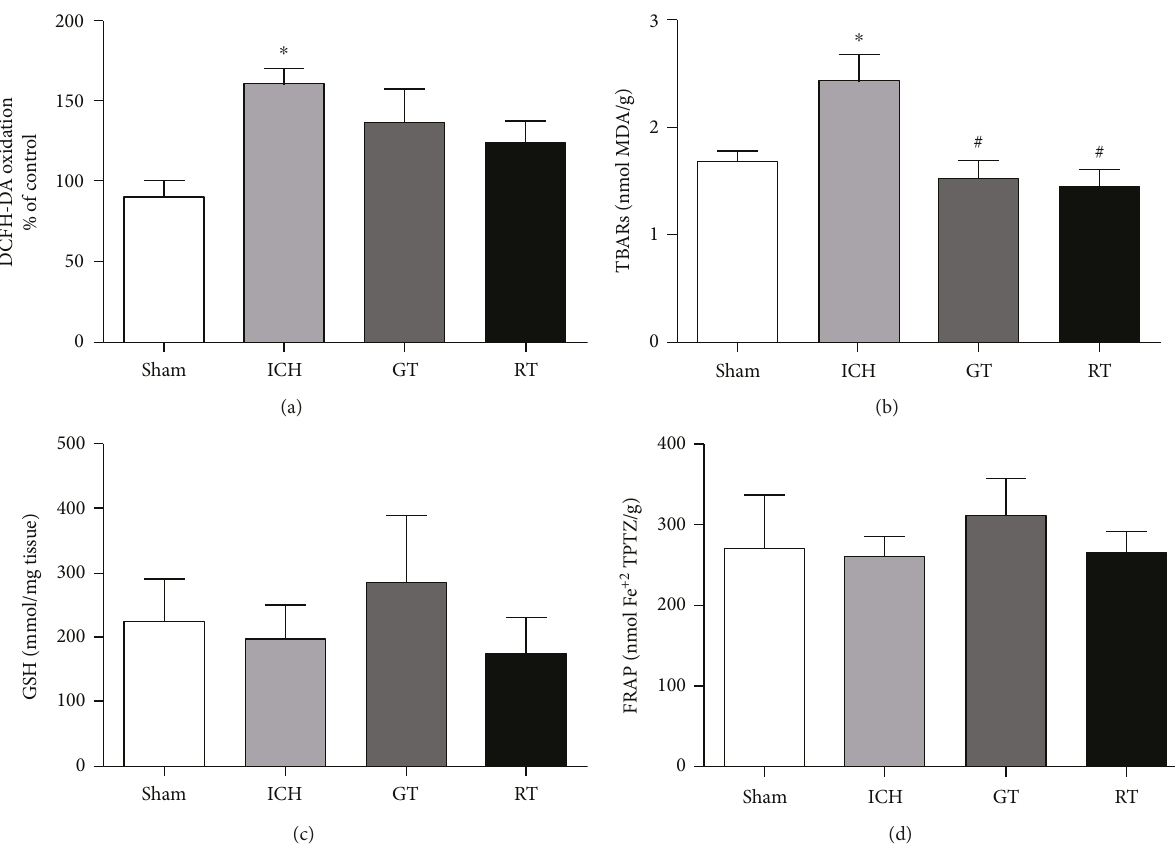
Figure 3: E ff ects of administration of green tea and red tea on oxidative stress, oxidative damage, and antioxidant markers on striatum after ICH in rats. (a) ROS levels by DCFH method; (b) lipid peroxidation by TBARS (thiobarbituric acid reactive substance); (c) glutathione levels (GSH); (d) total antioxidant capacity by FRAP method. Data are presented as the mean ± S.E.M. One-way ANOVA ∗ P < 0 05 in comparison to sham group; # P < 0 05 in comparison to ICH group ( n = 6